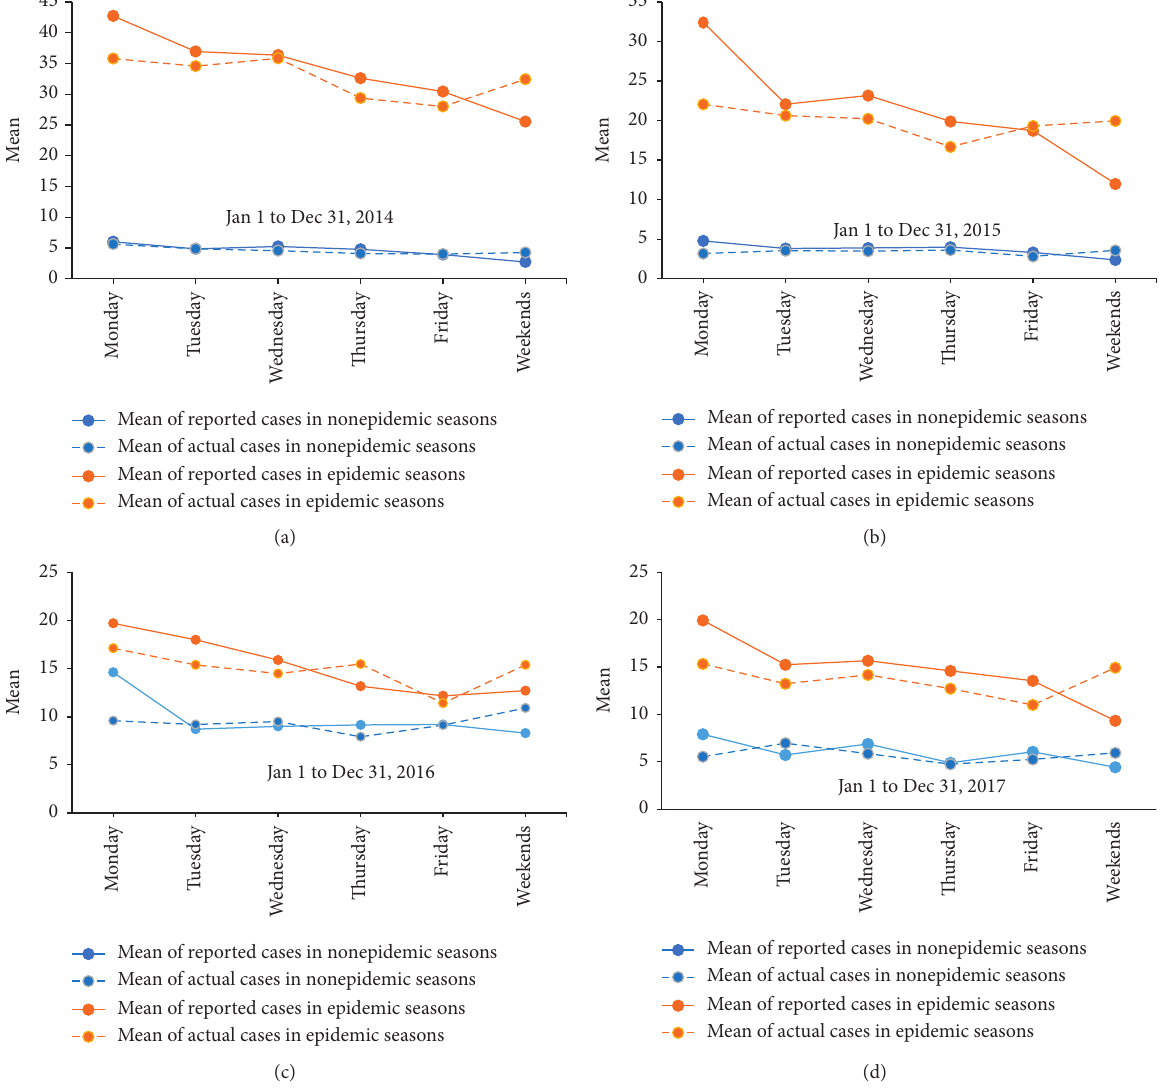
Figure 1: Distribution of weekly average actual cases and reported number of hand-foot-and-mouth disease cases between 2014 and 2017 in Hanzhong city,